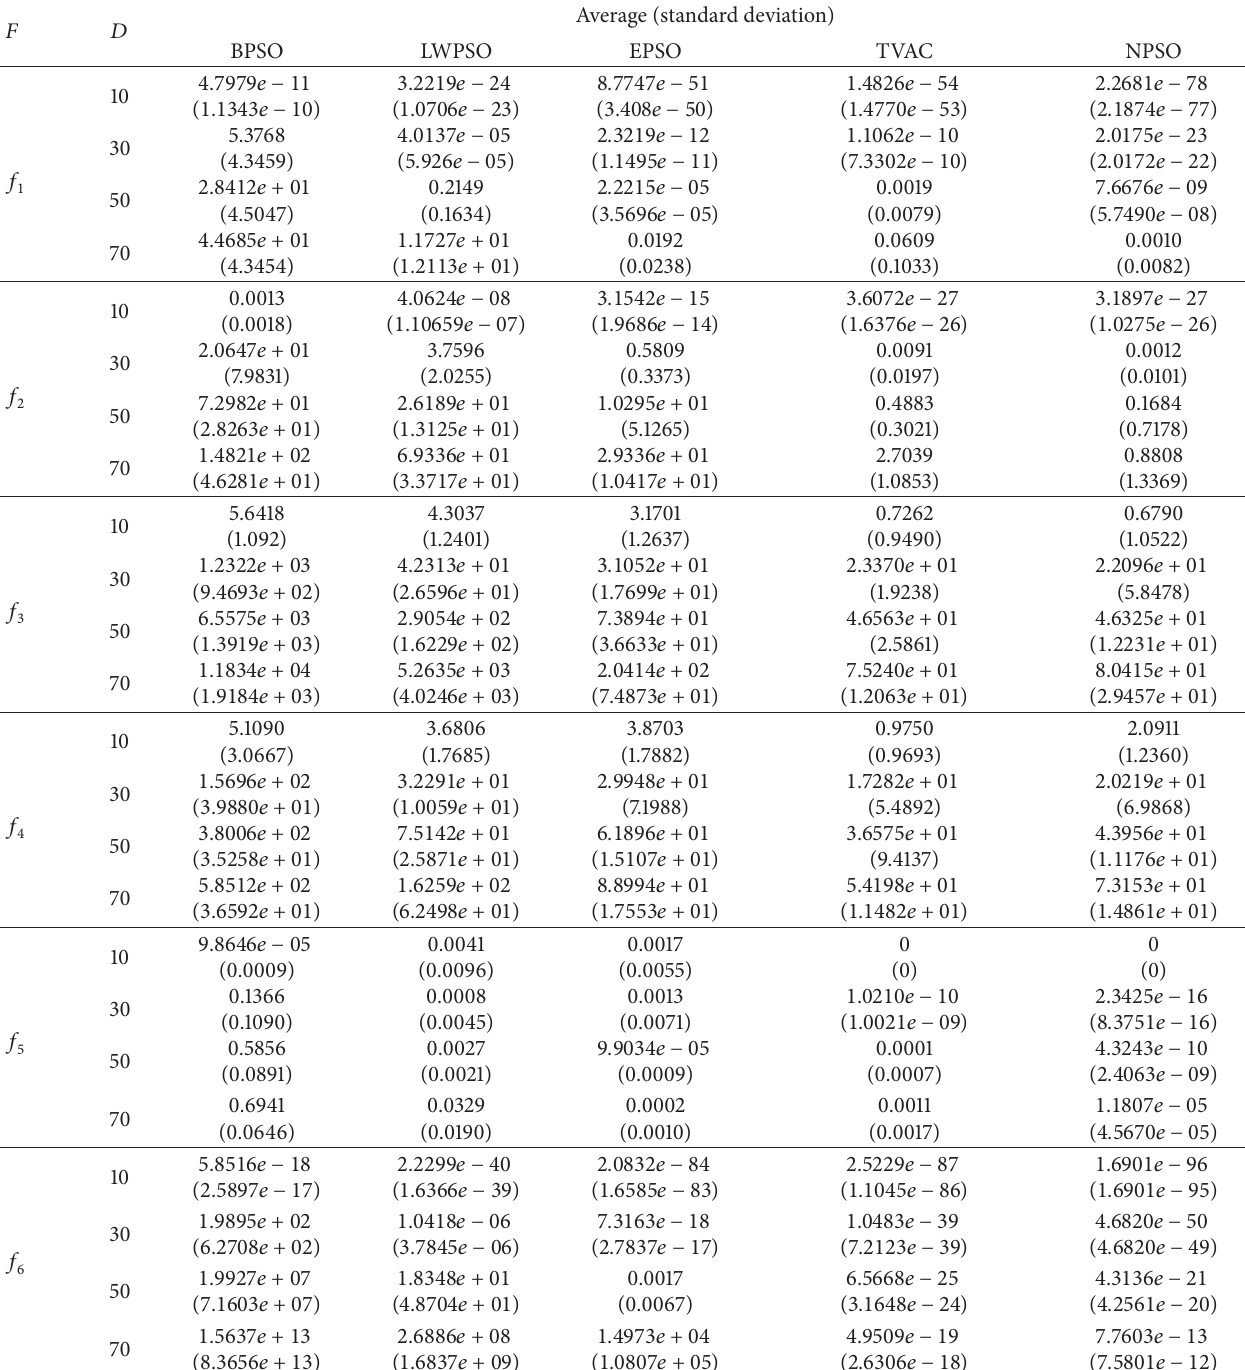
Table 2: Comparison between BPSO, LWPSO, EPSO, TVAC, and